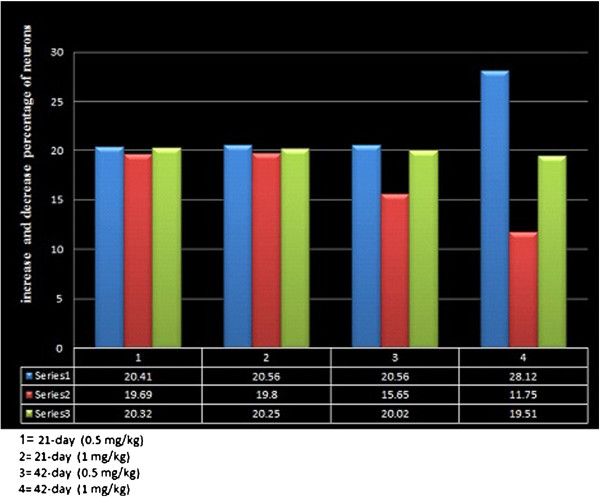
Investigation neuron increase and decrease percentage in experiment groups compared to the right ganglions of non-crushing sciatic nerve and control group.